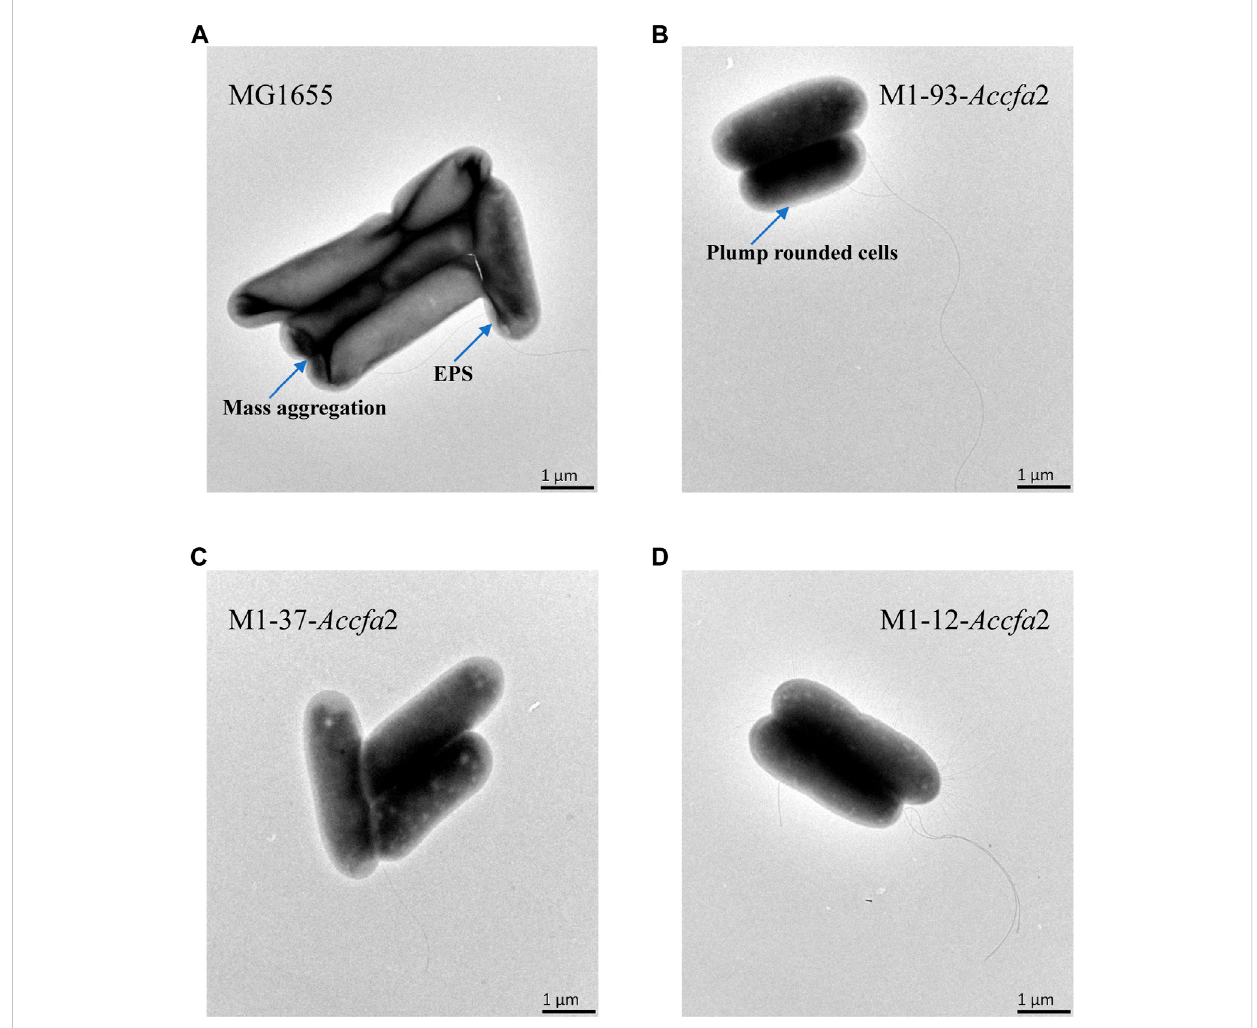
FIGURE 5 The morphological characteristics of strains MG1655 (A) , M1-93- Accfa 2 (B) , M1-37- Accfa 2 (C) and M1-12- Accfa 2 (D) treated with acid